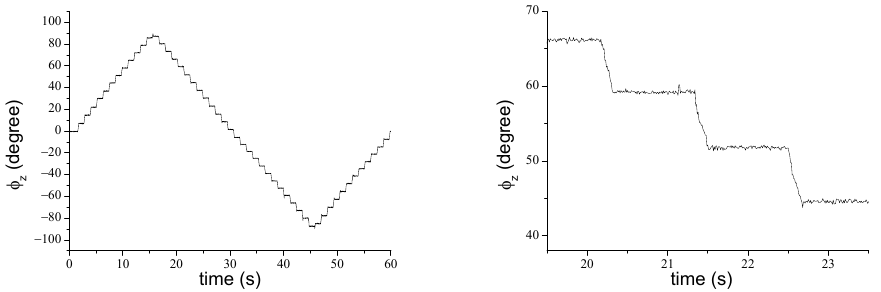
Figure 8. The magnet rotates in steps around the z axis on a circumference 8 mm in radius, each step corresponds to 360/51 = 7.06 ◦ and is followed by 100 trackings in static conditions. The non-monotonic behavior of the trace in the first plot is caused by the arcsin inversion, and can be numerically overcome. The zoomed plot at right provides a visual estimation of the precision, while the ramp (non)linearity accounts for the accuracy limits.